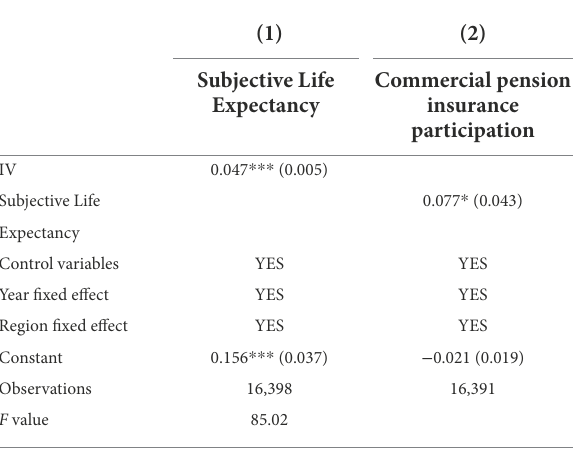
TABLE 3 Estimation results of IV